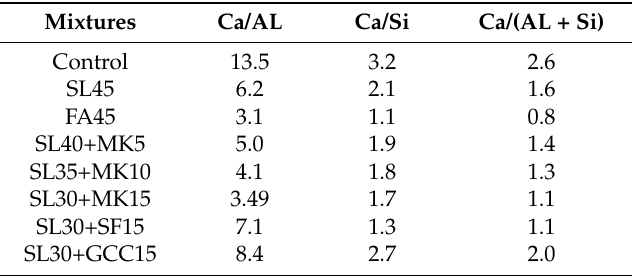
Table 4. Oxide ratios for select 45%